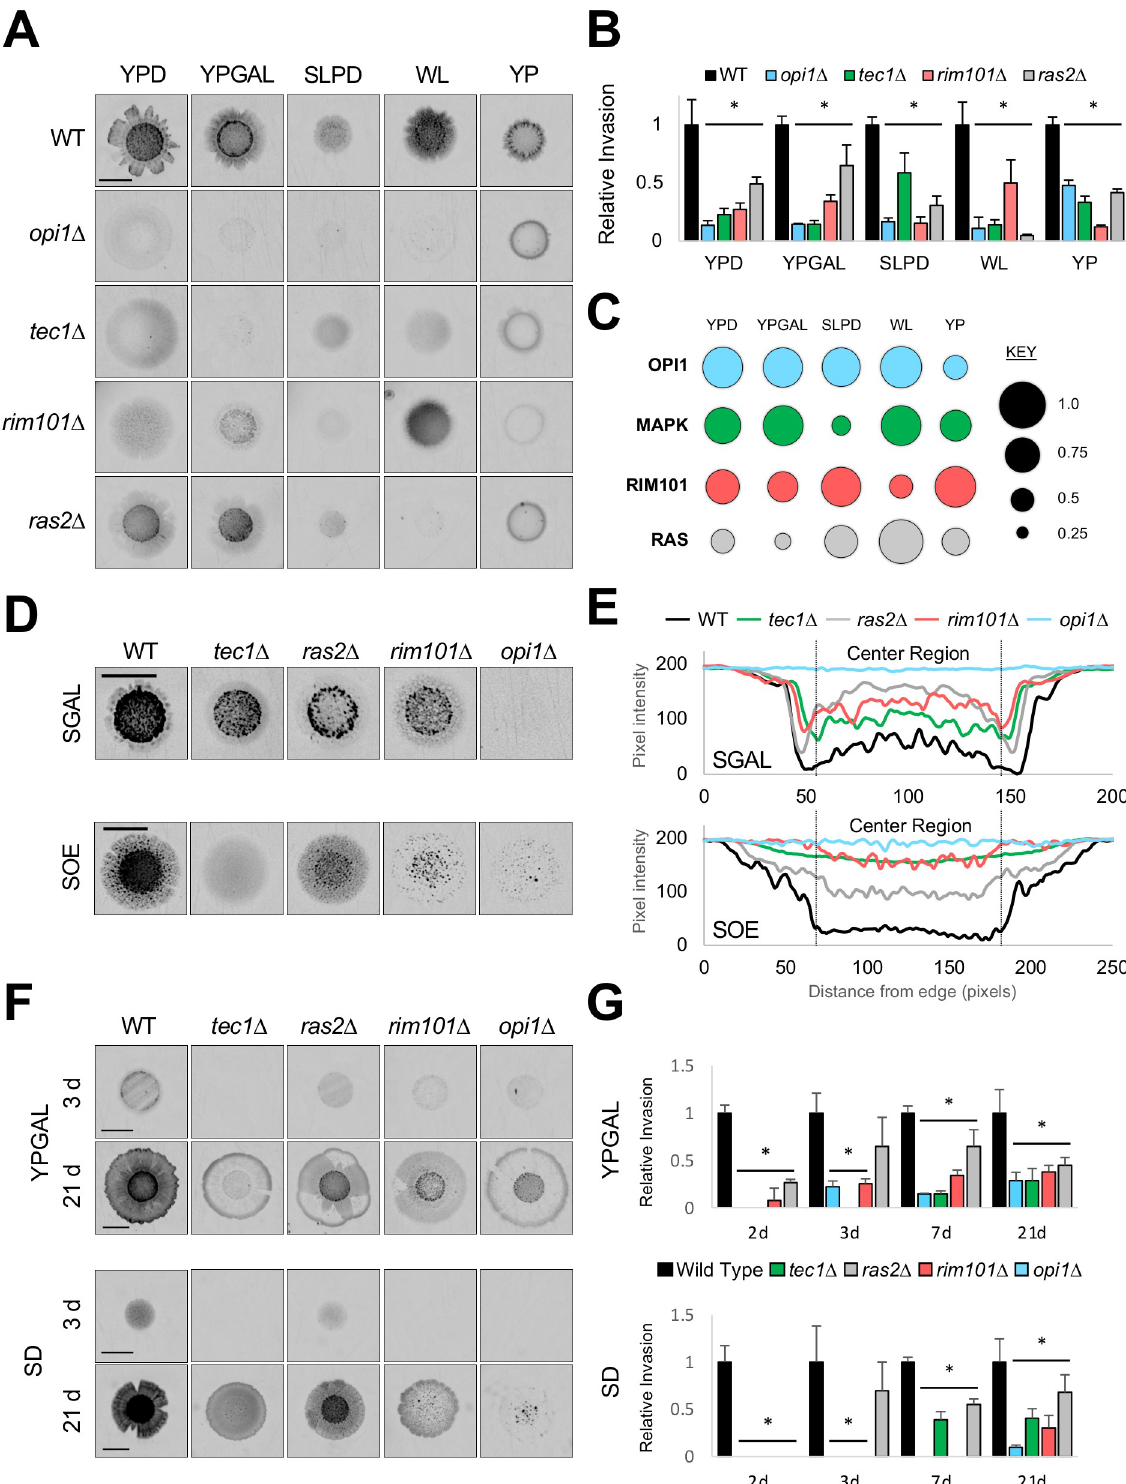
Fig 2. Contribution of the main invasive growth regulators across environments, microenvironments, and over time. A) PWA. Inverted images of invasive scars after wash, bar, 0.5 cm. Colonies prior to wash in S1 Fig . B) Levels of relative invasion to wild type, with wild type values set to 1. Asterisk, P-value � 0.05, compared to wild type. C) Model of pathway contributions to invasive growth. Circle size is proportional to pathway contribution. D) PWA, see panel A for details. E) Plot profile of invasive growth across invasive scars. Strains and